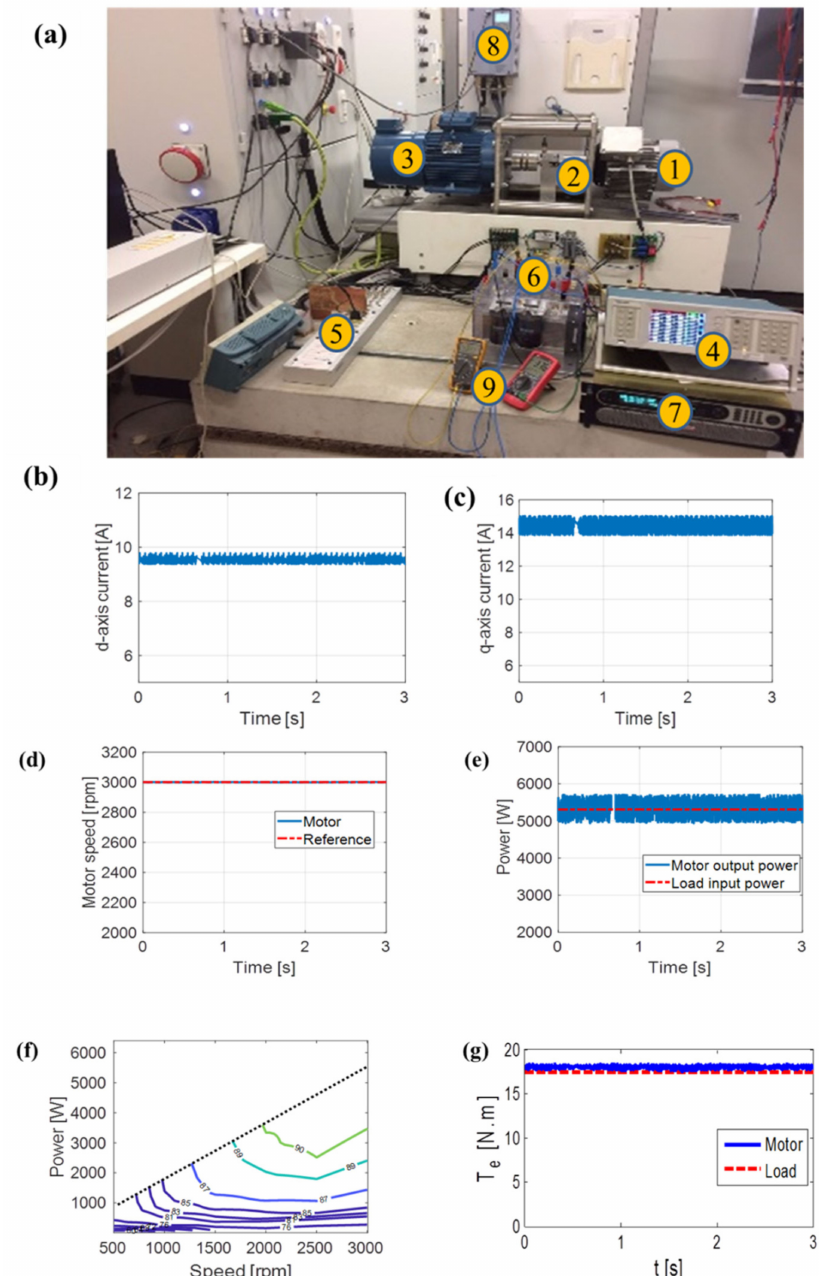
Figure 13. Experimental test bench ( a ). dq-axis current components ( b , c ). ( d ) SynRM measured speed versus time. ( e ) Power of the SynRM and pump at rated condition. ( f ) Efficiency map of the whole drive system. ( g ) The measured SynRM and reference load torques as a function of